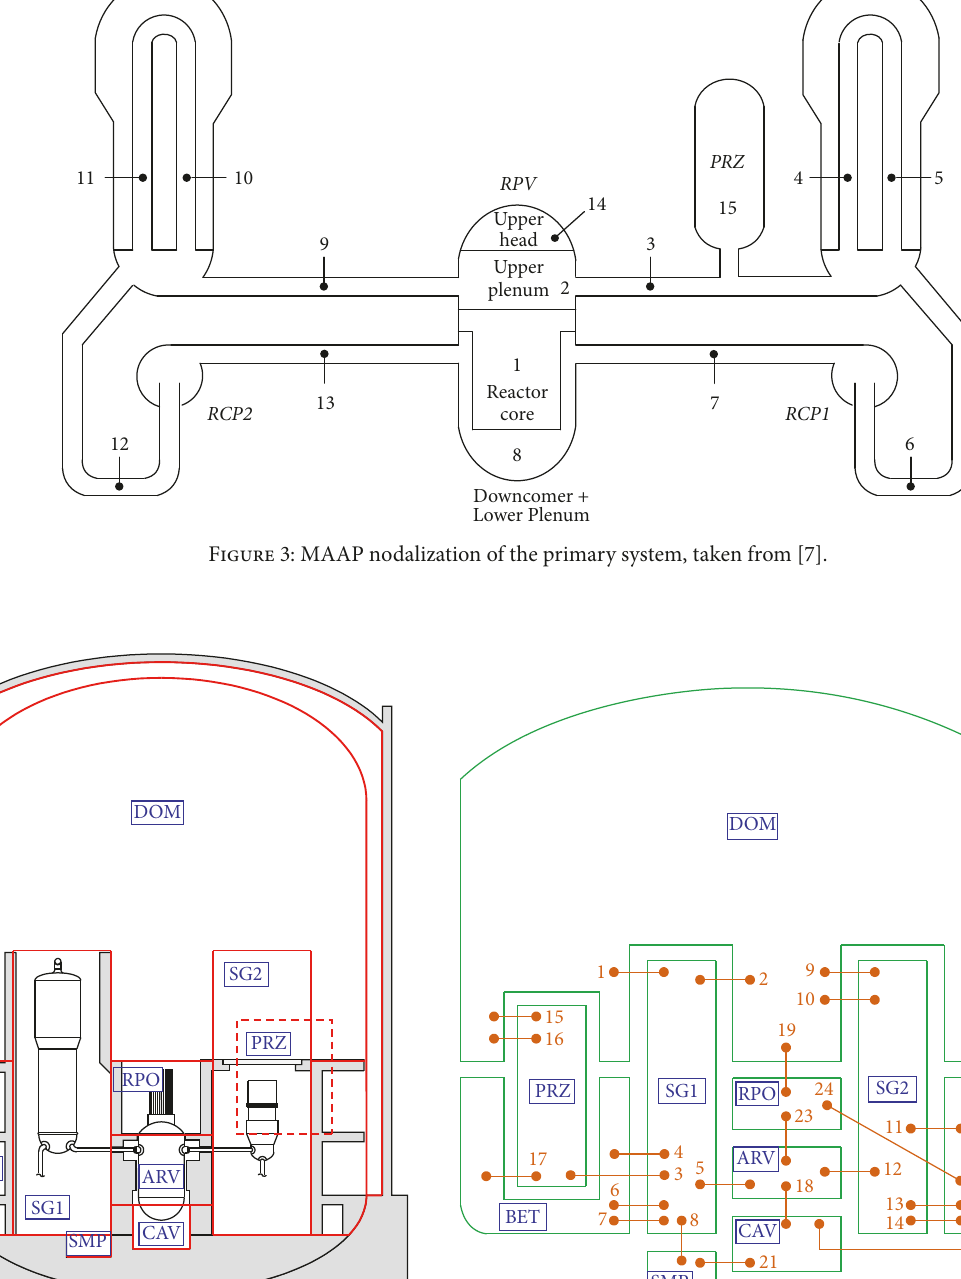
The containment building is represented with 10 control